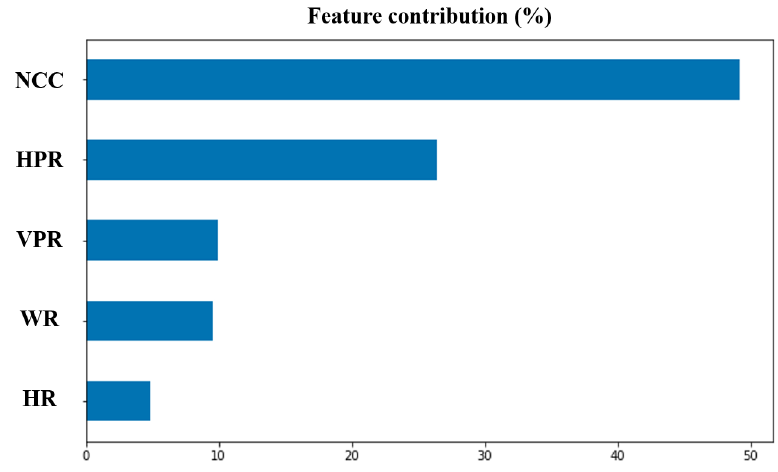
Figure 19. Relative feature importances upon constructing matchingClassifier.